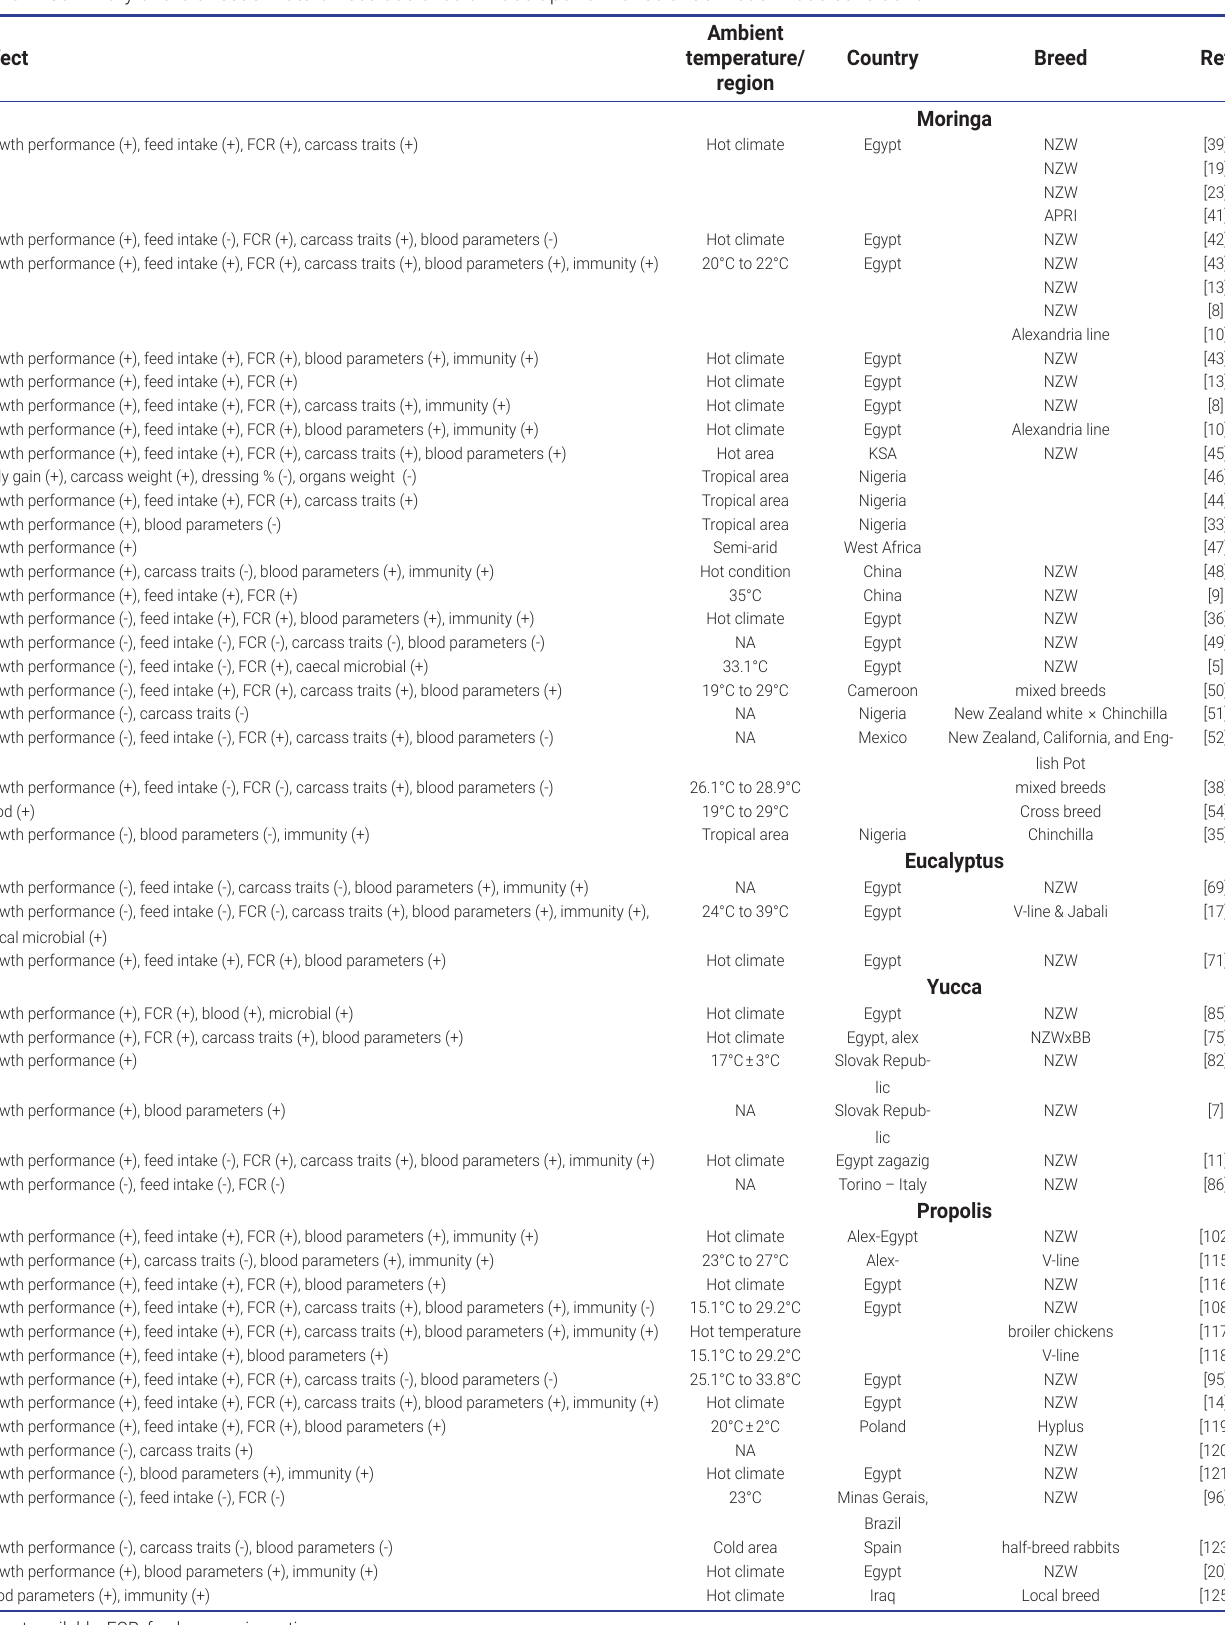
NA, not available; FCR, feed conversion ratio. Plus sign stands for trait improvement and minus sign stands for trait